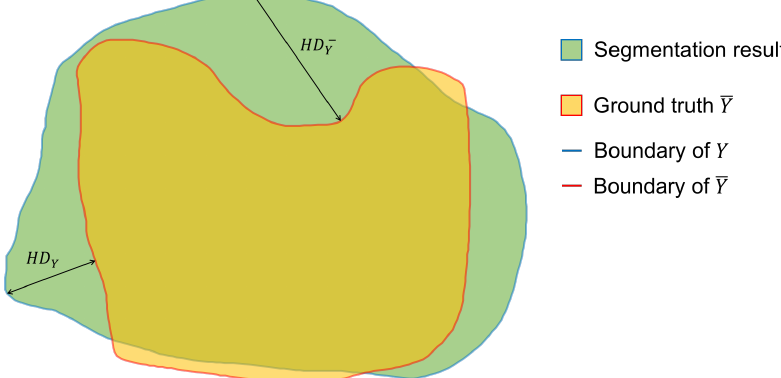
Figure 6. The intuitive description of Hausdorff distance between segmentation result Y i and ground truth Y